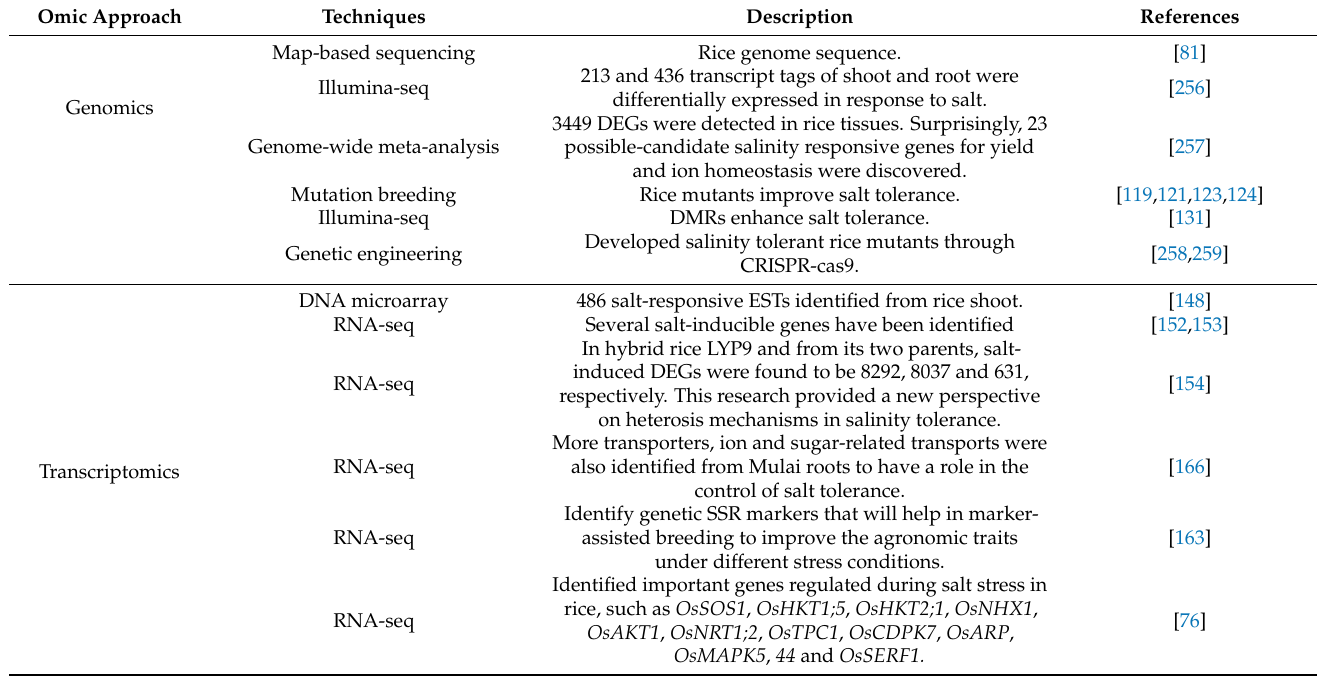
Table 2. A review of recent omics platforms used in the rice salinity